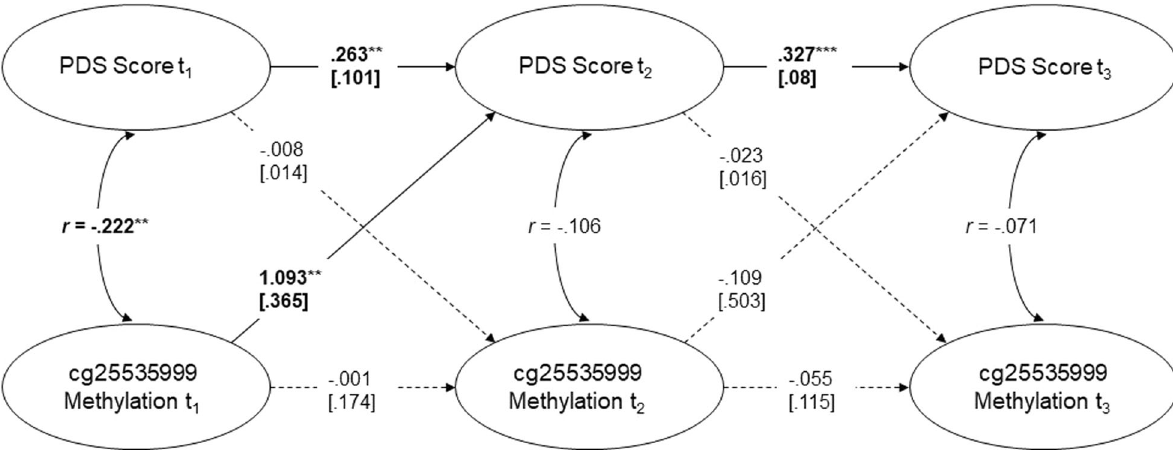
Fig. 2 Displayed is the constructed Structural Equation Model (SEM) together with the regression or correlation coef fi cients. Signi fi cant associations are marked in bold. * p < 0.05, ** p < 0.01, *** p <